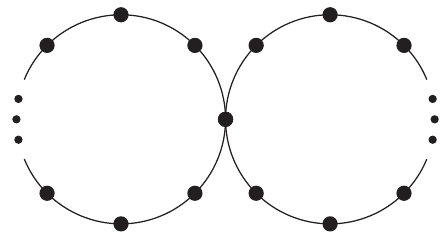
Figure 10: Graph for degree sequence d ∗∗ . Comparison of 8 α +(54) α and 2 (31) α